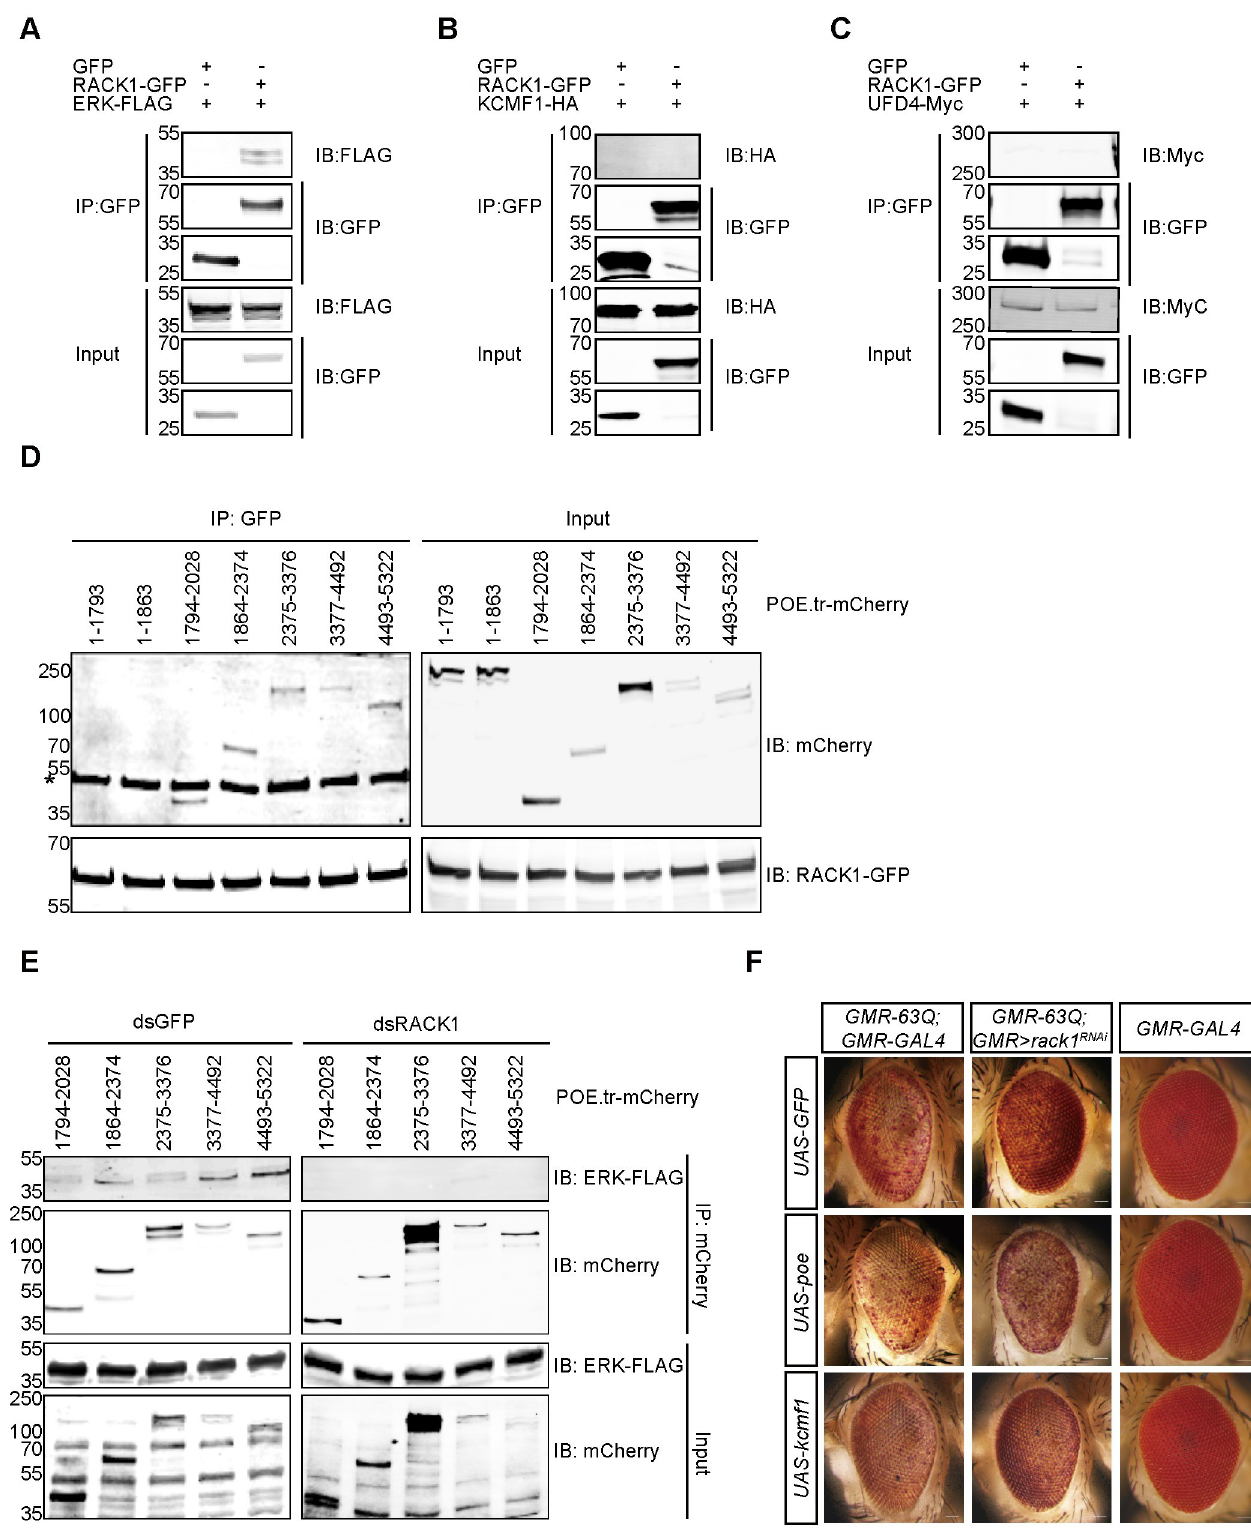
Fig 7. RACK1 scaffolds POE and ERK. (A-C) RACK1 specifically interacts with ERK. FLAG-tagged ERK (A), HA-tagged KCMF1 (B) or Myc-tagged UFD4 (C) was co-expressed in S2 cells with GFP or RACK1-GFP, followed by immunoprecipitation with anti-GFP antibody. (D) Different mCherry-tagged